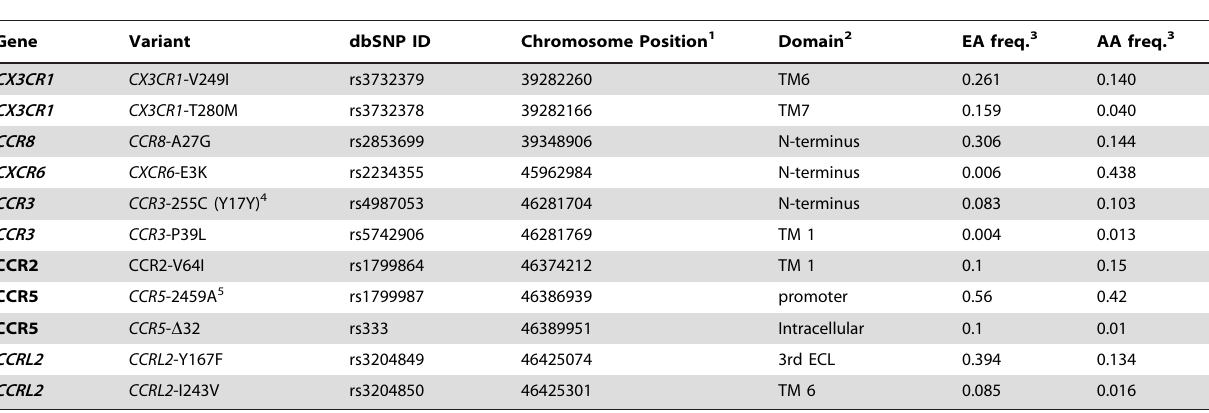
Table 1. Characteristics and allele frequencies of the chemokine receptor